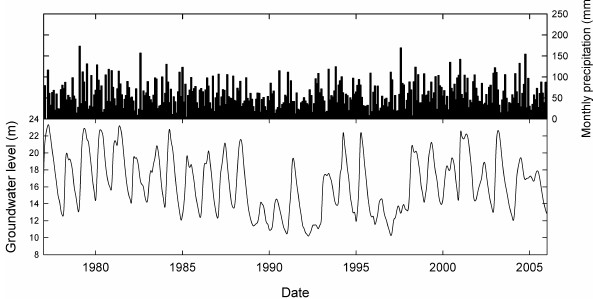
Fig. 3. Histogram showing monthly precipitation totals (one month aggregation) and corresponding monthly groundwater level hydro- graph for Dalton Holme for the period of 1977 to end of